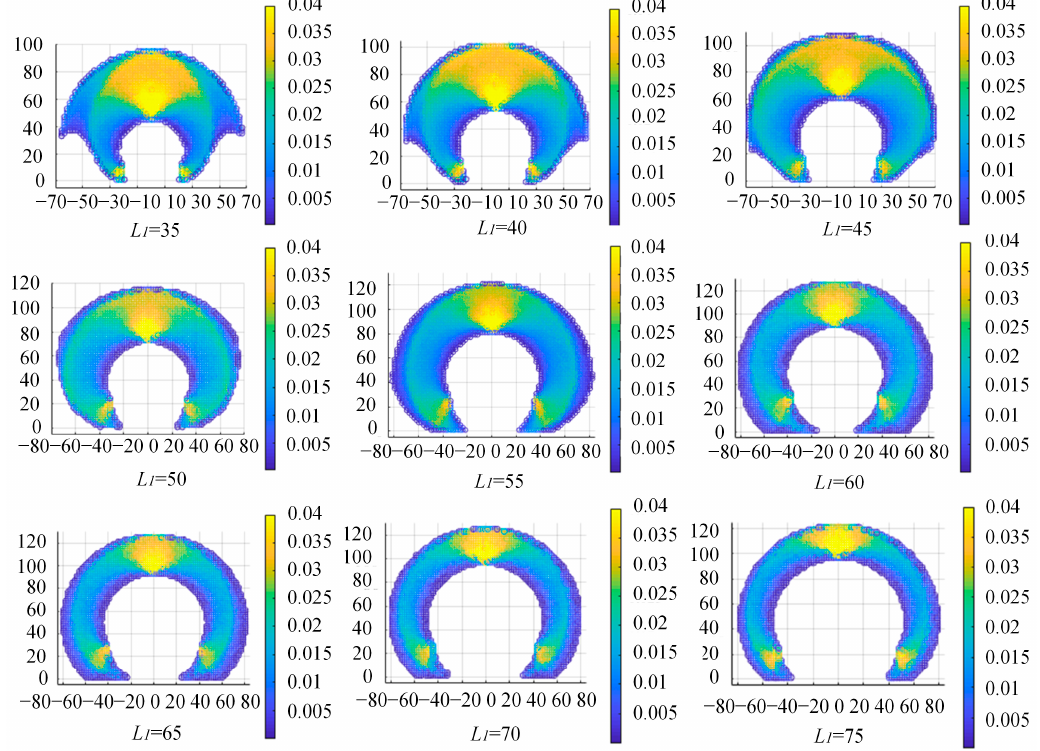
Figure 13. The dexterity of the continuum robot with different length distributions. Table 5. The dexterity indices of the CCR with different length ratios.